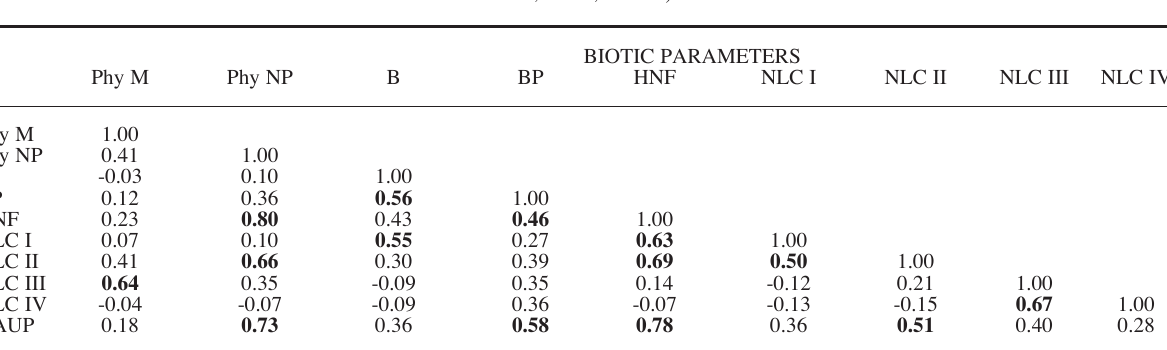
T ABLE 2. – Pearson’s correlation coefficients between the biomass values of bacteria, heterotrophic nanoflagellates, nonloricate ciliates, copepod nauplii and concentration of phytoplankton chlorophyll a and bacterial production (Significant correlation coefficients are printed in bold; N=20,